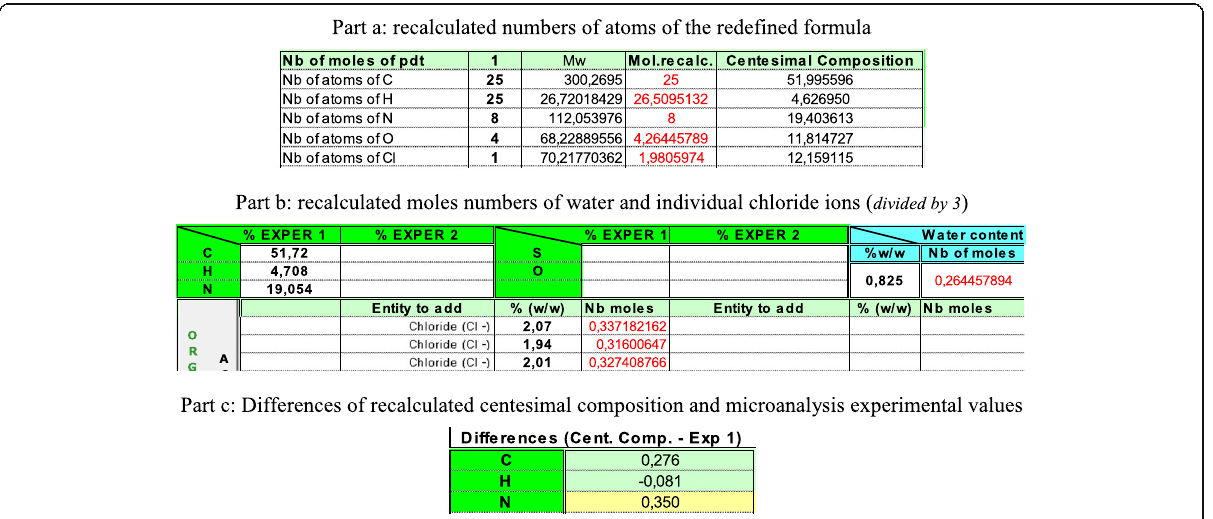
Fig. 6 User interface screenshots (parts a, b, c) –– Mat-CHN exploitation tacking into account the first set of results for the compound C 25 H 25 N 8 O 4 Cl, HCl